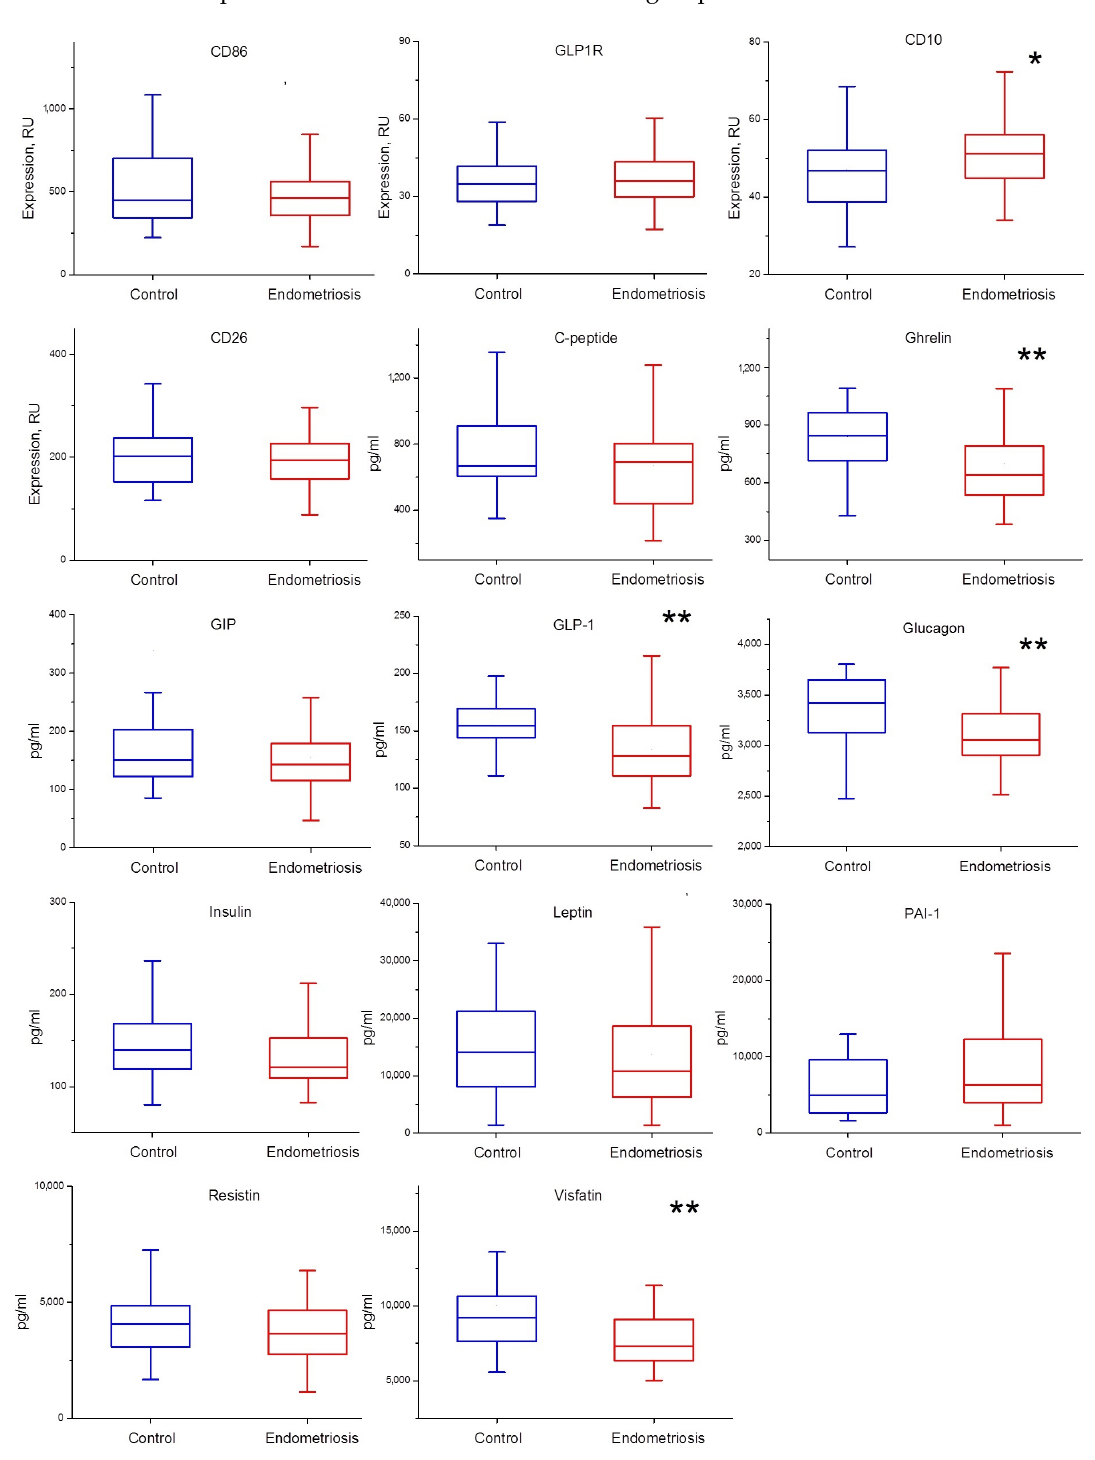
Figure 1. Concentrations of energy metabolism factors in the PF in control and endometriosis groups, *— p < 0.05, **— p <